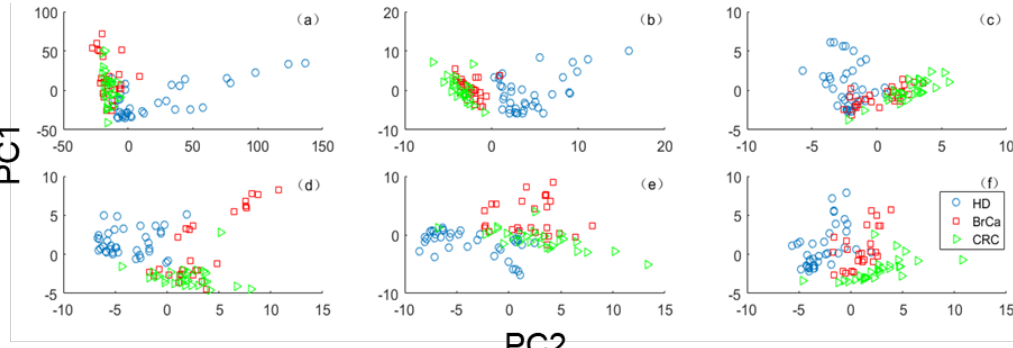
Figure 6. Principal component scores scatter plot (PC 1 × PC 2) of Dataset 11 with different features: